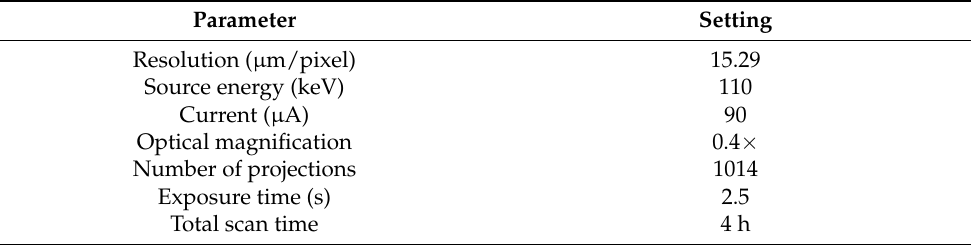
Table 2. XCT can